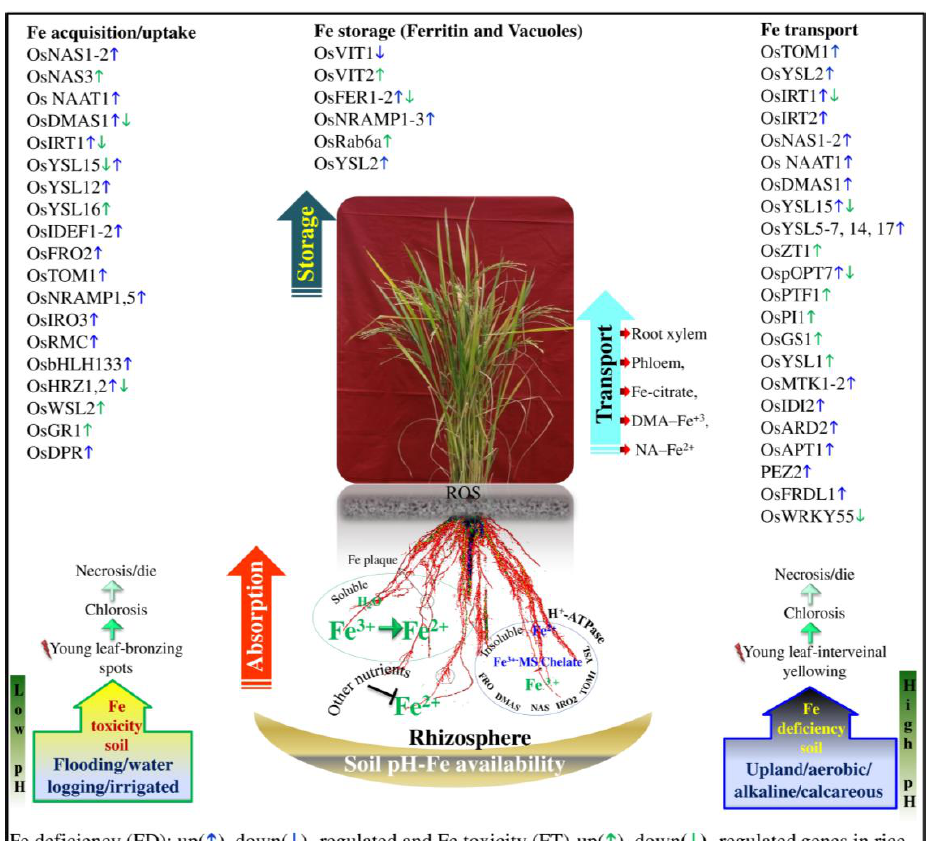
Figure 1. Diagram of Fe toxicity (FT) and Fe deficiency (FD) tolerance genes showing changes in transcriptional levels (up-regulation or down-regulation indicated by arrows) through microarray and transcriptomics studies.